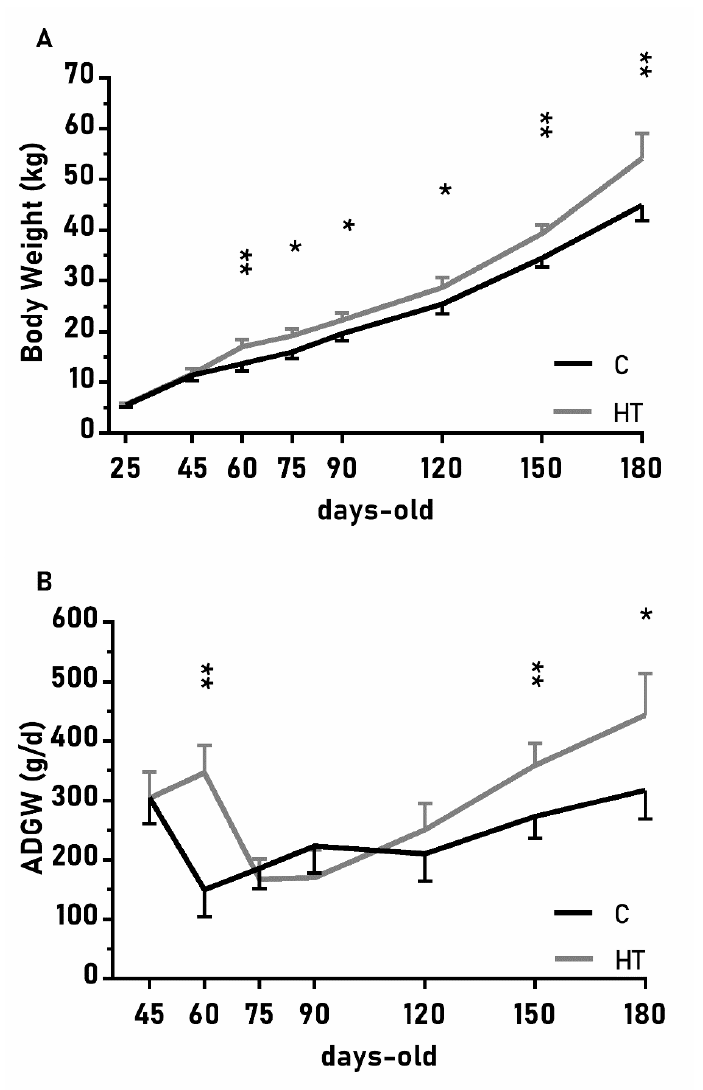
Figure 2. Mean values ( ± S.E.M.) of ( A ) body weight and ( B ) average daily weight gain (ADWG) from weaning at 25 days-old to 180 days-old in pigs born from sows treated or not with hydroxytyrosol during pregnancy (groups HT, grey line, and C, black line, respectively). Asterisks denote significant di ff erences between groups (*: p < 0.05, **: p <